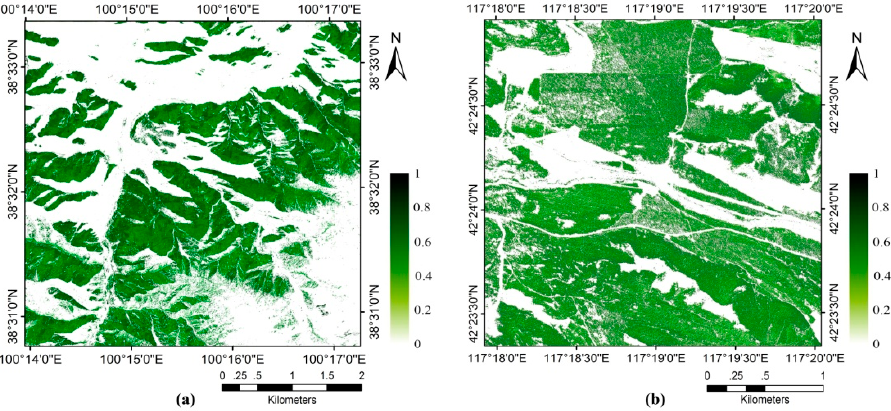
Figure 11. FAPAR calculation of the study areas at Dayekou ( a ) and Saihanba ( b ).